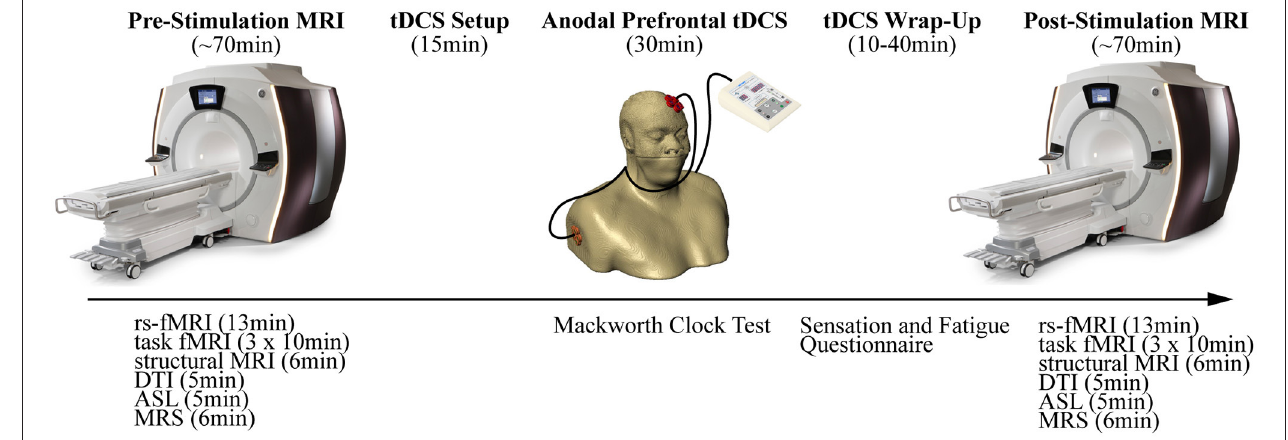
FIGURE 1 | Overview of the experimental design depicting the procedures. Each session began with a pre-stimulation MRI. Participants were then removed from the MRI and anodal prefrontal transcranial direct current stimulation (tDCS) was applied. Finally, a post-stimulation MRI repeated the procedures from the pre-stimulation MRI.